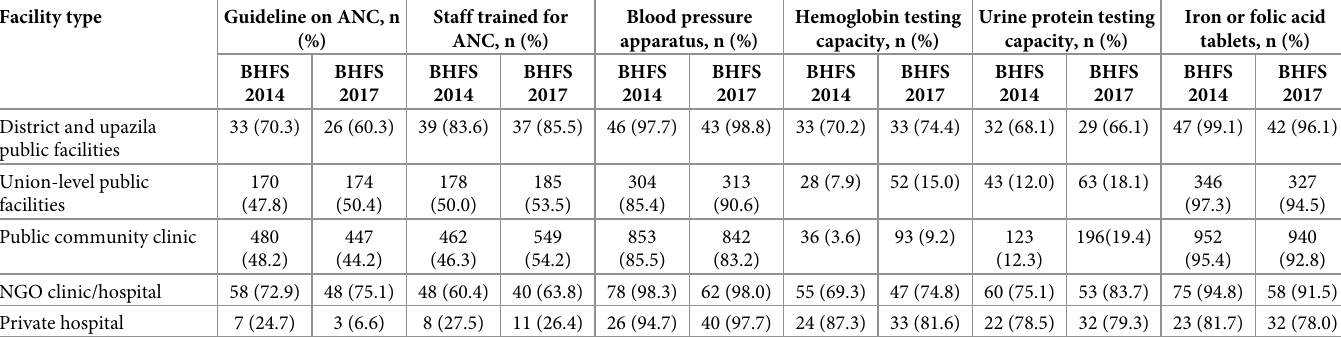
Table 2. Distribution of tracer indicators for ANC service preparedness by facility type. Guideline on ANC, n